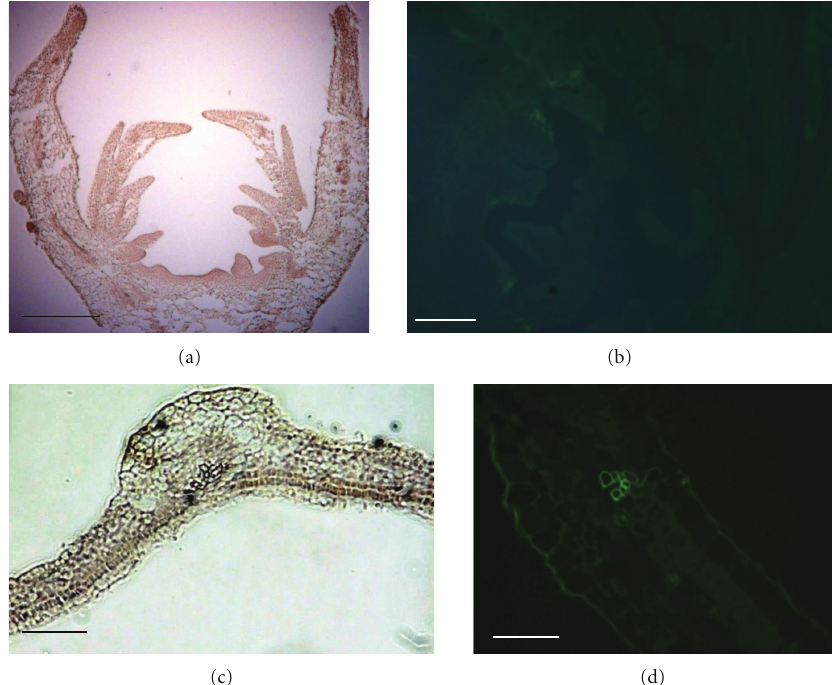
Figure 1: Negative control of Rosa hybrida flower buds and leaves (a), (c) Dnase and PCR treated sections. RT step is omitted; (b), (d) PCR-treated sections without primers. Bar = 50 μ